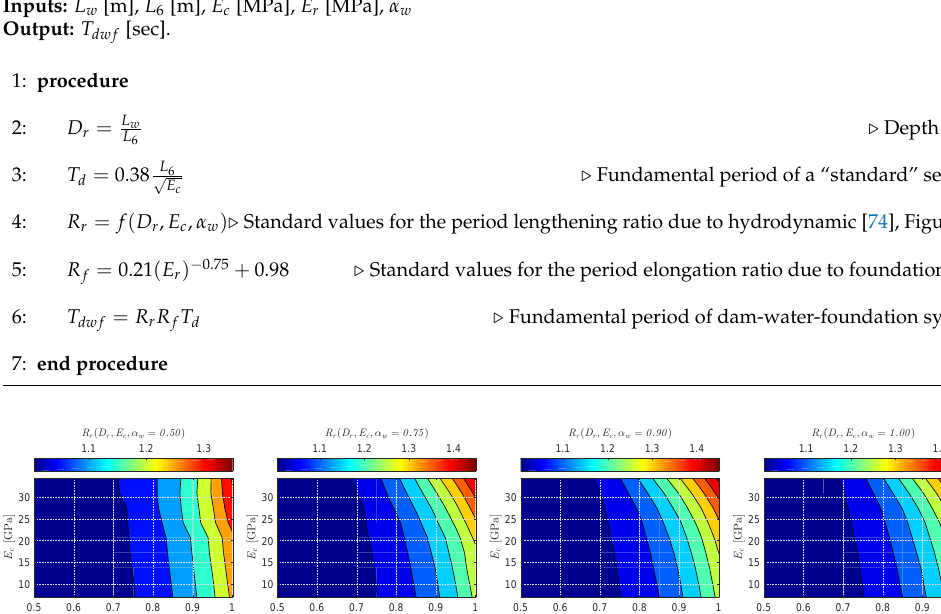
Algorithm 1 Estimation of the fundamental period of the coupled system [74,75].